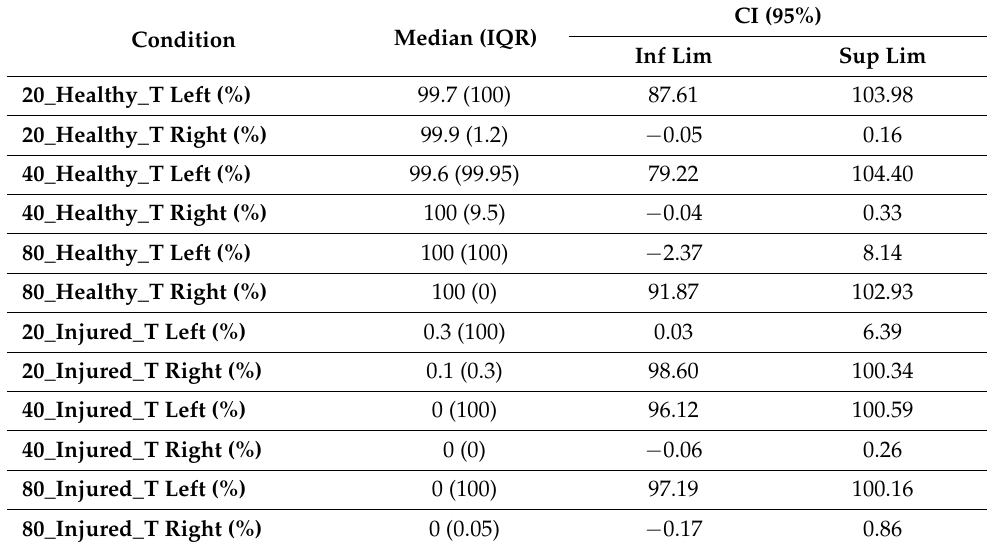
Table A1. Descriptive data (median, interquartile range, coefficient interval 95%) of echotype i, ii, iii,